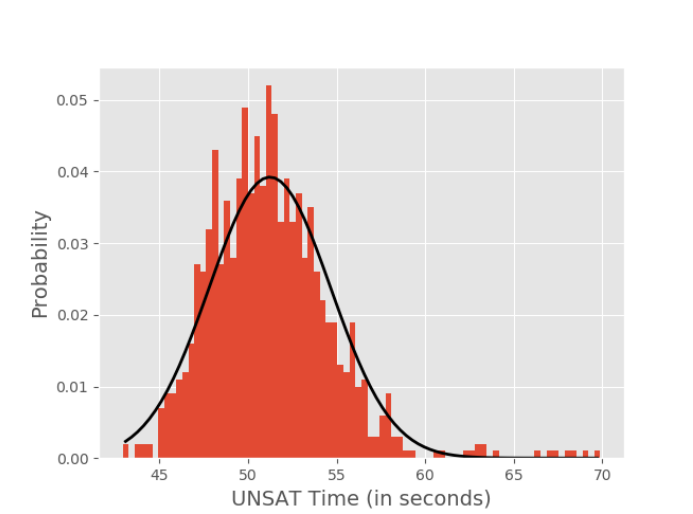
Figure 2: Histogram of the SAT solver abort